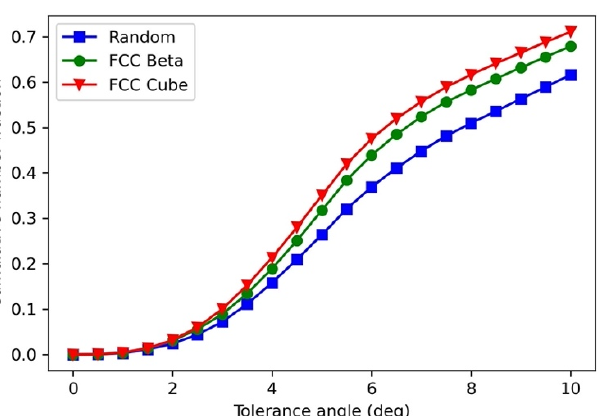
Figure 1. Number fraction of parent austenite GBs allowing for a double YKS orientation relationship as a function of the allowed tolerance.